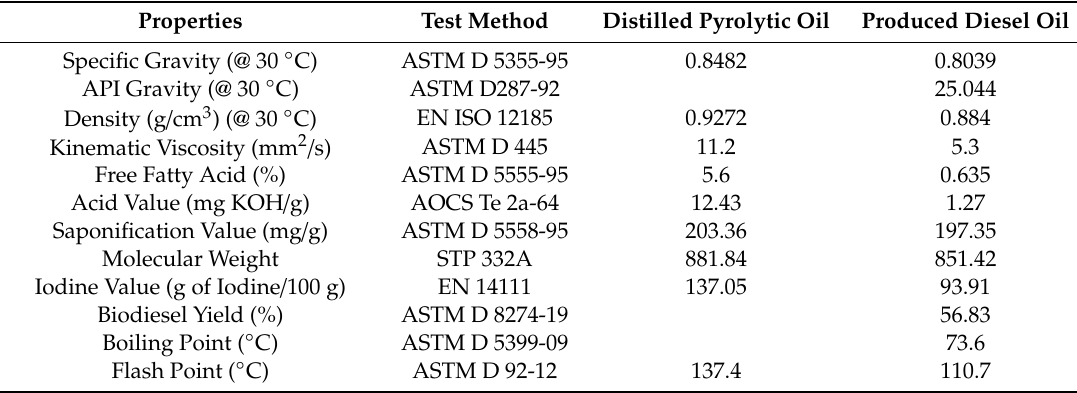
Table 3. Physicochemical analysis of distilled pyrolytic and biodiesel oil samples.